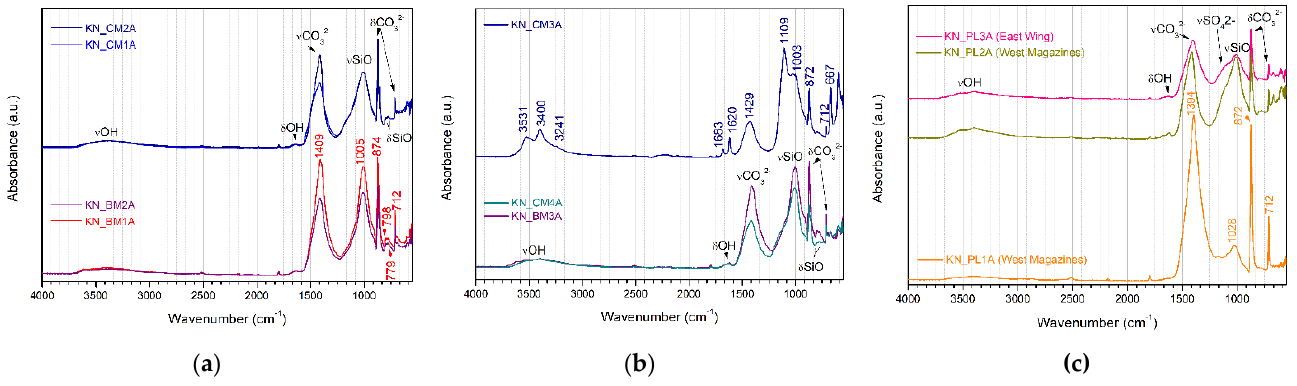
Figure 5. FTIR spectra for samples collected at Knossos Palace: ( a ) results of the bedding samples of west magazines; ( b ) results of East Wing bedding samples; ( c ) results of samples with render function.